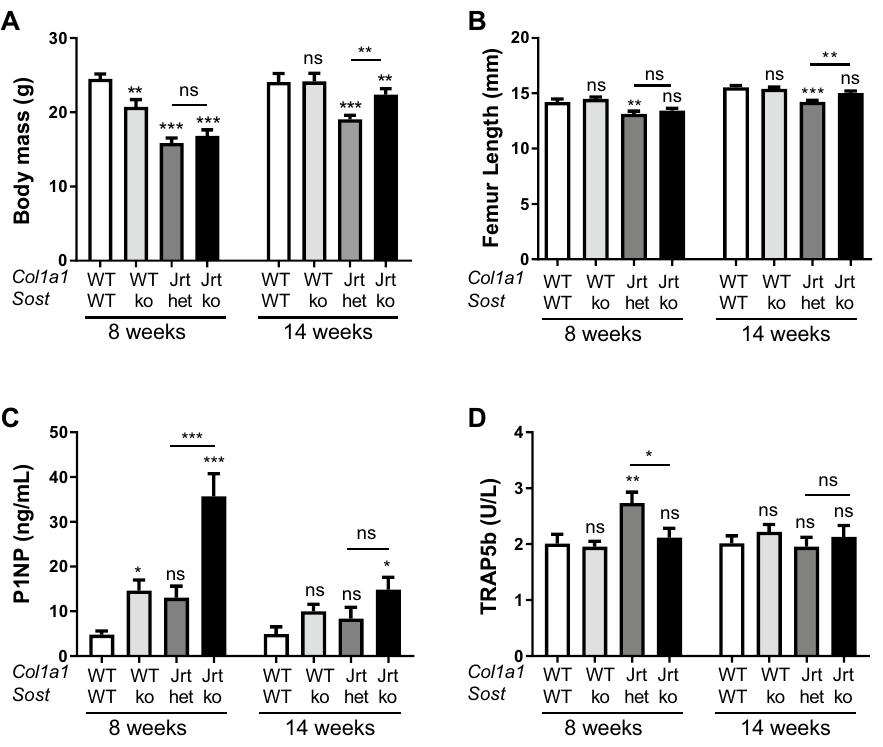
Figure 2. Body mass, femur length and serum markers of bone metabolism. Variation with genotype and age in body mass, femur length, and serum markers of bone metabolism. Error bars represent standard errors. Significance levels for differences to WT mice (ANOVA) are indicated above each bar: *p < 0.05, **p < 0.01, ***p < 0.001, ns: not significant (p ≥ 0.05). Significance levels for differences between Jrt;Sost-het and Jrt;Sost-ko are indicated above the horizontal lines. n = 8–15 mice per group for body mass and femur length. n = 6–11 mice per group for serum